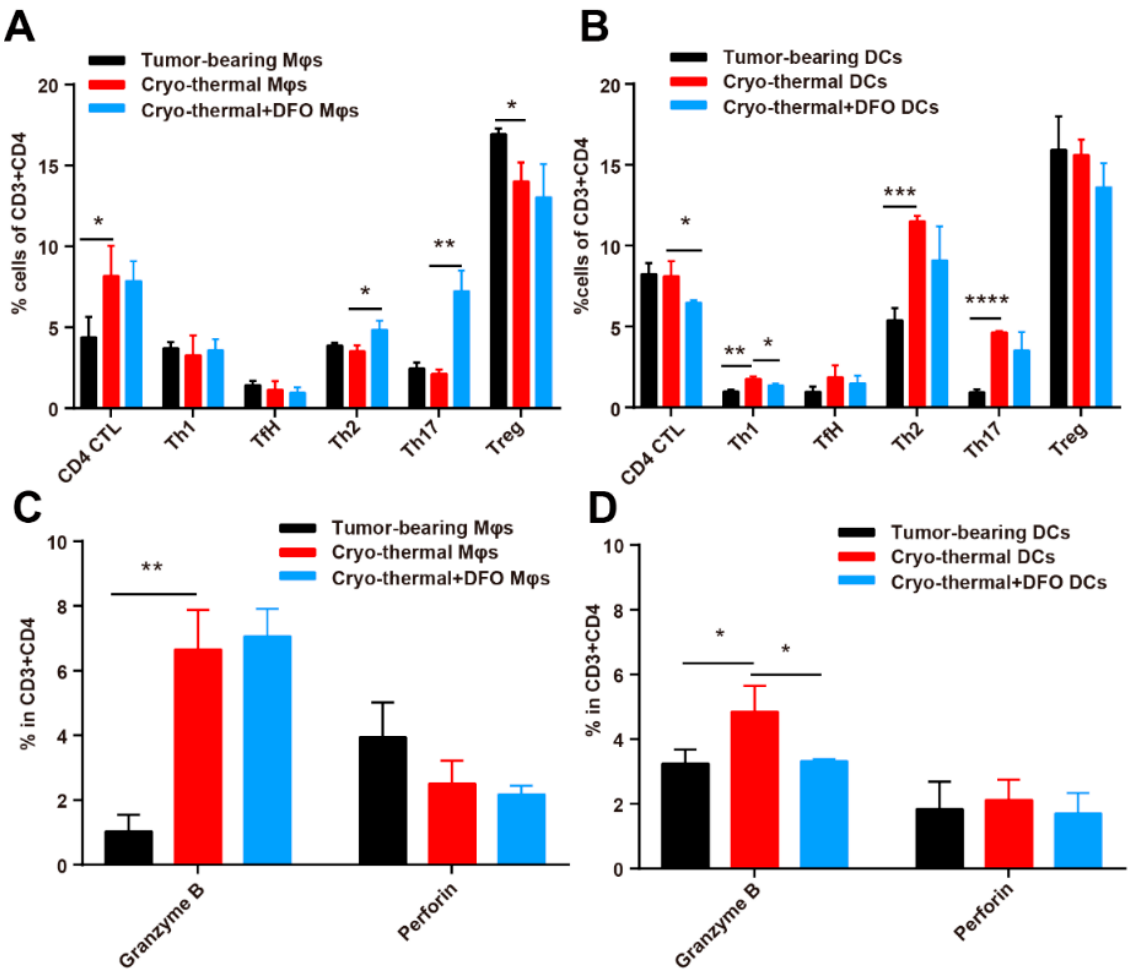
Figure 8. Iron-induced macrophages and DCs after cryo-thermal therapy promoted the differentiation of CD4 CTL. Mice were sacrificed and spleens were harvested 72 h after cryo-thermal therapy. Macrophages and DCs were sorted from tumor-bearing mice, cryo-thermal group and DFO treated cryo-thermal group mice and cocultured with CD4 + T cells for 24 h. ( A , B ) CD4 CTL (Thpok − ), Th1 (IFN- γ + ), Tfh (Bcl6 + ), Th2 (IL-4 + ), Th17 (IL-17 + ) and Treg (Foxp3 + ) subsets in CD4 + T cells were measured by using flow cytometry. ( C , D ) Intracellular granzyme B and perforin in CD4 + T cells were determined by flow cytometry. * p < 0.05, ** p < 0.01, *** p < 0.001, **** p < 0.0001, n = 3 for each group.